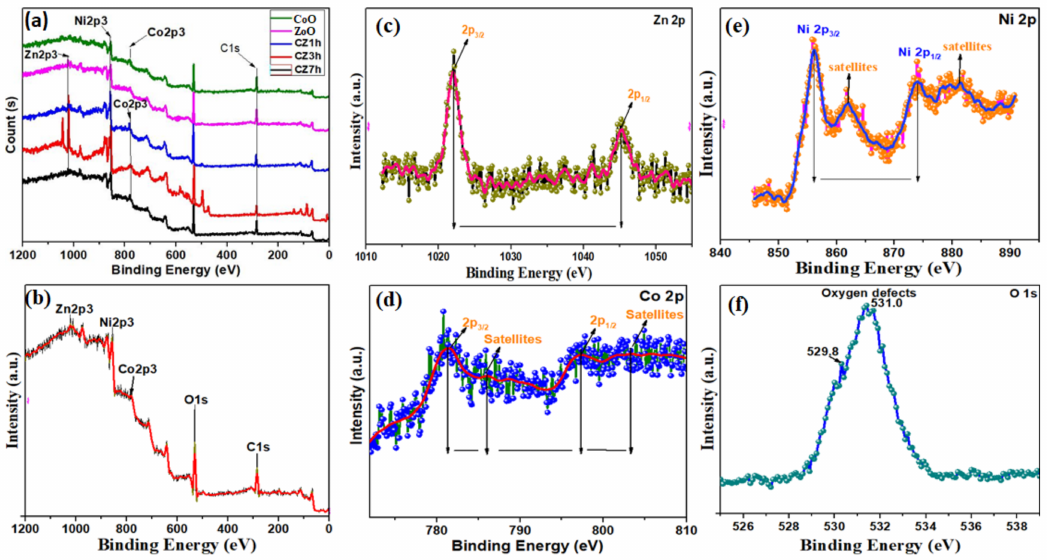
Figure 6. Shows the X-ray photoelectron spectroscopy (XPS) of ( a ) all samples and XPS spectra of CZ3h of ( b ) survey spectrum, ( c ) Zn 2p, ( d ) Co2p, ( e ) Ni 2p and ( f ) O